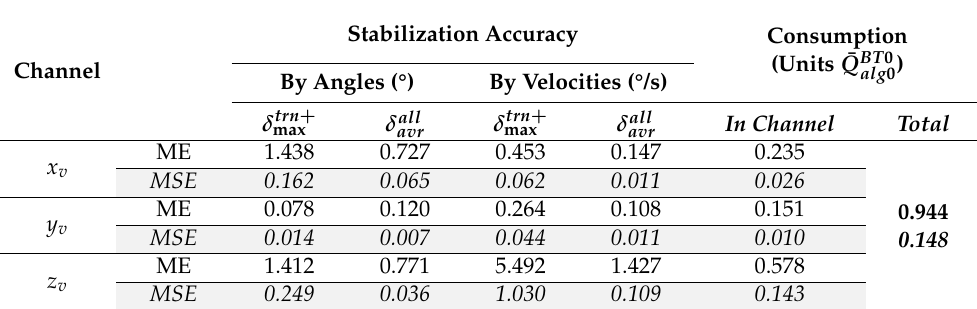
Figure 4. Typical process of stabilization of the lander without roll overturns according to the new algorithm. Table 5. Statistics of lander stabilization processes without roll overturns according to the new